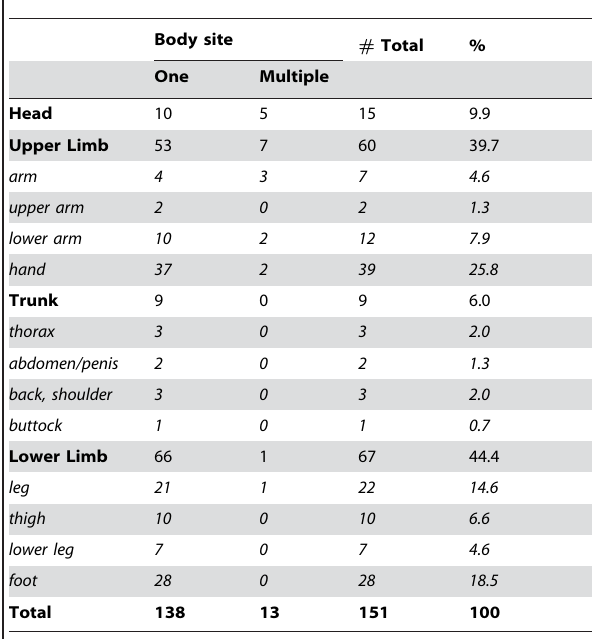
Table 2. Details of the body localization of the wounds inflicted by dFAT positive animals in one body site or at multiple sites in the